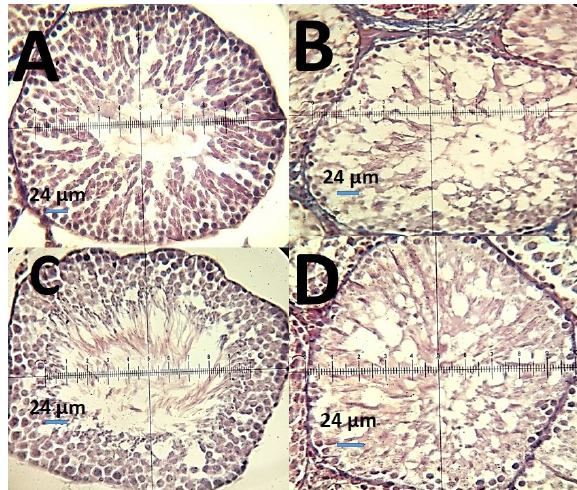
Figure 7. (A): Light micrograph of the testis of a control rat with normal histology. B: Testis of a rat treated with Se powder; arrow indicates testicular degeneration. Arrow point shows degeneration of seminiferous tubules (PAS stain. Mic. Mag. × 40). C: Light micrograph of the testis of a control rat and a treated with Se powder (D) (H&E staining. Mic. Mag. ×